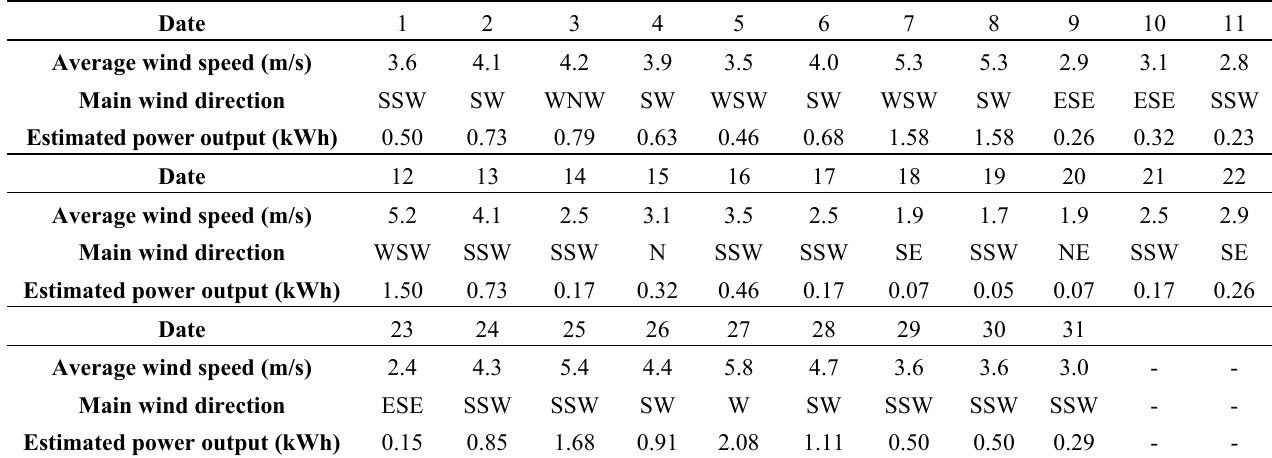
Table A5. Estimated power output per day in May.